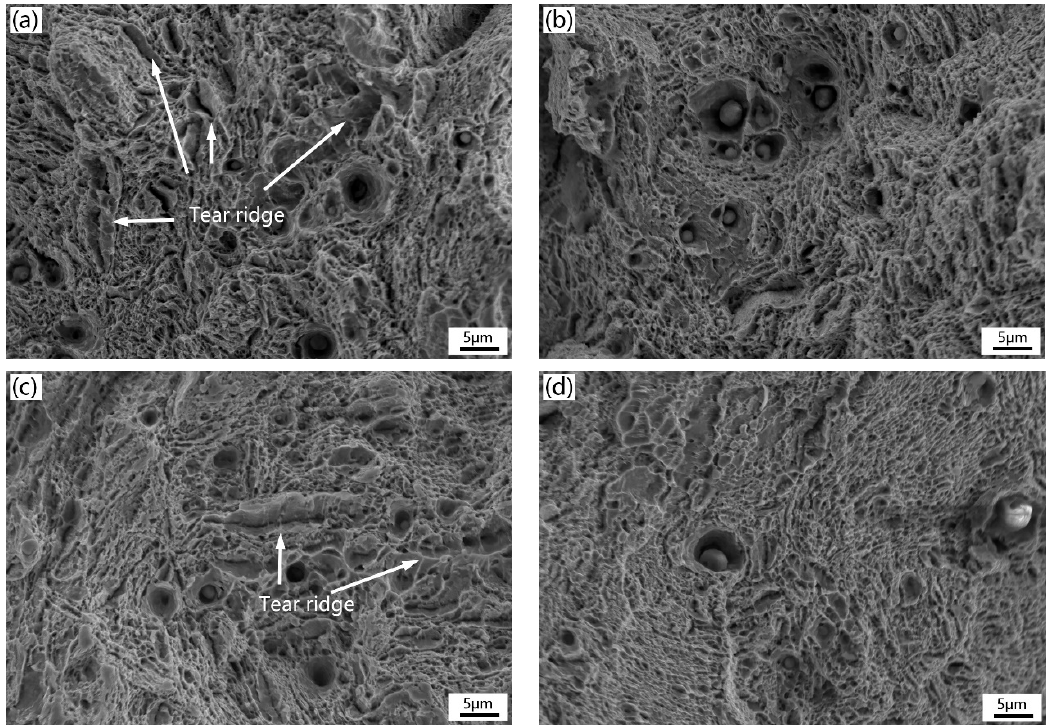
Figure 12. Images of tensile fracture morphology: ( a ) 1L (low Si and low temperature), ( b ) 1H (low Si and high temperature), ( c ) 2L (high Si and low temperature), and ( d ) 2H (high Si and high temperature).